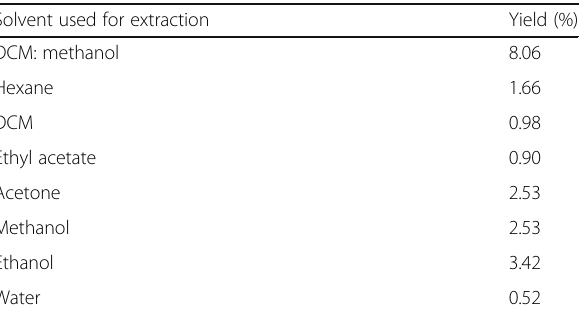
Table 1 Yield of extracts from leaves of T . welwitschii Solvent used for extraction